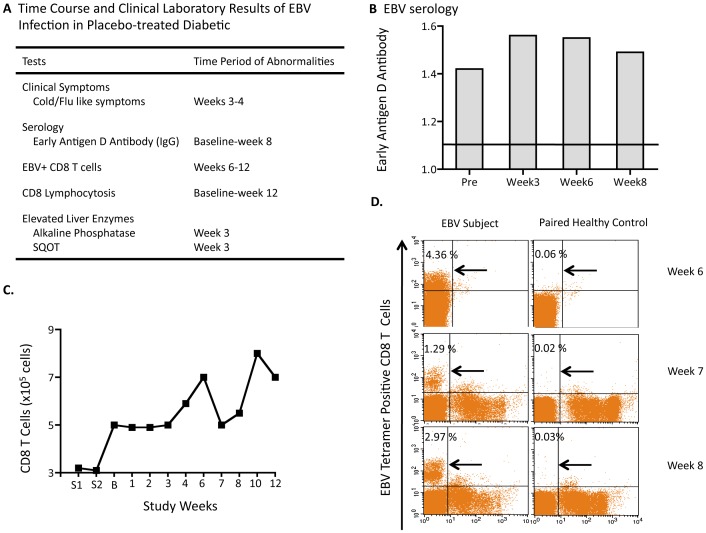
Clinical laboratory studies reveal acute EBV infection in placebo-treated diabetic.(A) Weekly course of EBV infection from serum of diabetic subject #vi (B) Positive Early Antigen D antibody versus negative values. (C) CD8 T-cell proliferative response. (D) Flow scatter plots of appearance of EBV-reactive T-cells vs. paired control, week 6 to 8. All newly appearing EBV-reactive T-cells were viable.